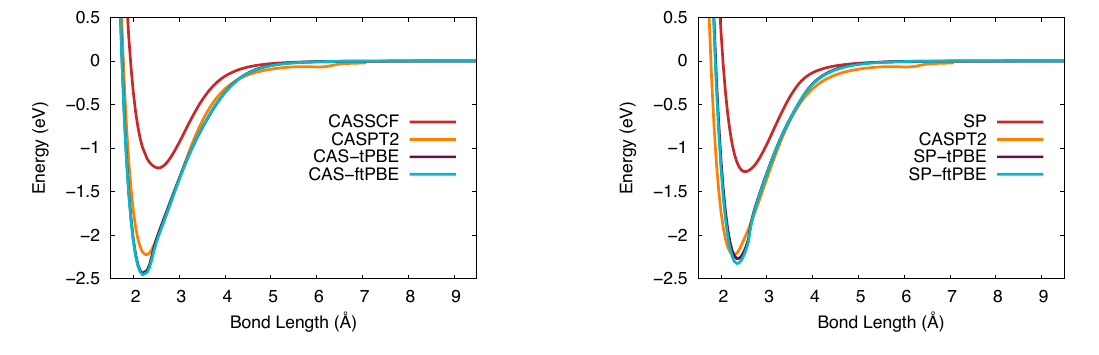
Figure 5. The potential energy curve for vanadium silicide in the 2 ∆ ground state. ( Left ): CASSCF (red), CASPT2 (orange), CAS-tPBE (purple), CAS-ftPBE (blue). ( Right ): SP (red), SP-tPBE (purple), SP-ftPBE (blue), CASPT2 (orange).